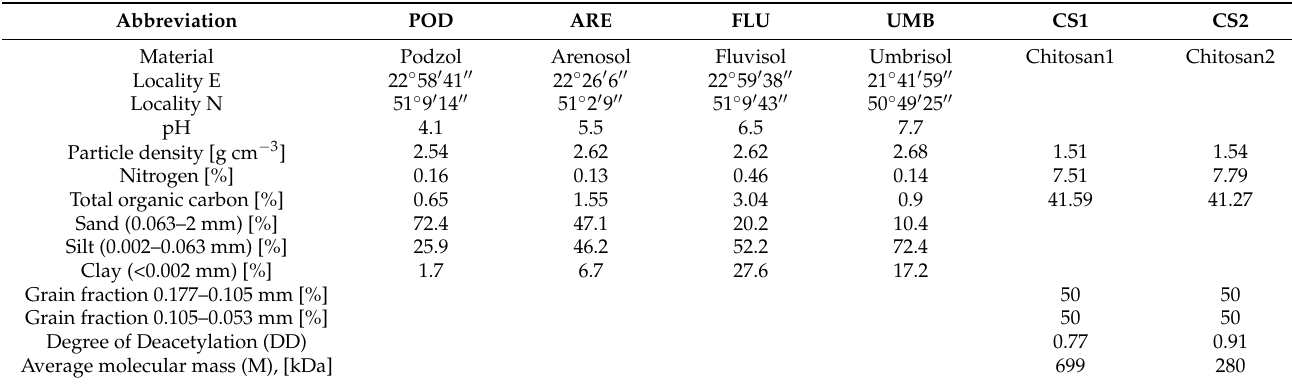
Table 1. Characteristics of the studied soils and